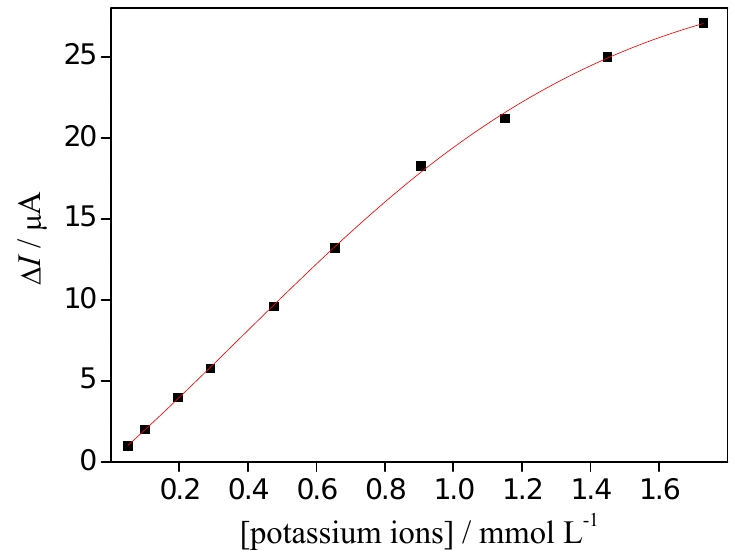
Figure 7. Calibration curve for potassium ion using sensor based on hollandite-type manganese oxide. Potential step: –0.25 V to 0.80 V vs . SCE. Stirring rate: 300